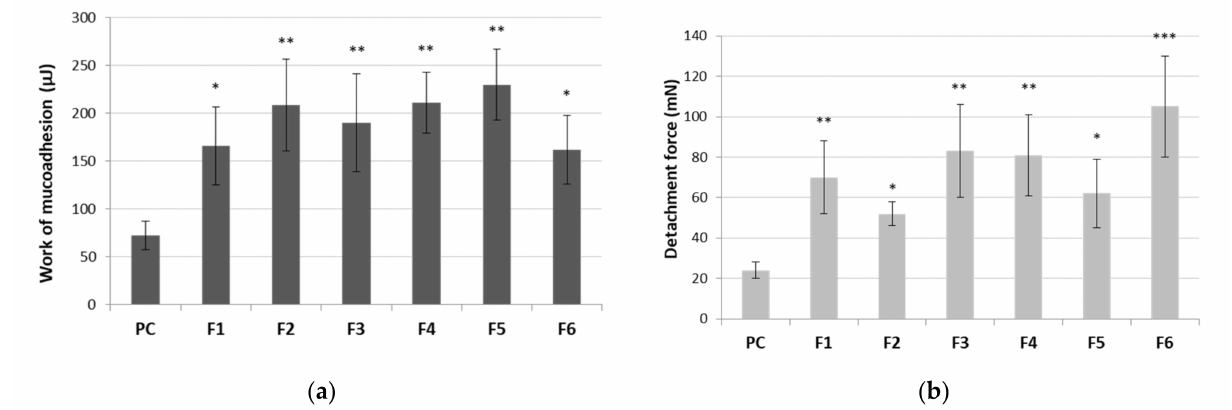
Figure 8. Work of mucoadhesion ( a ) and maximum detachment strength ( b ) of tablets containing cyclodextrin-based Polygoni cuspidati extract (F1–F6) ( n = 5; mean ± SD). * represents significance with p ≤ 0.05, ** with p ≤ 0.01 and *** with p ≤ 0.001 in comparison to cellulose paper control